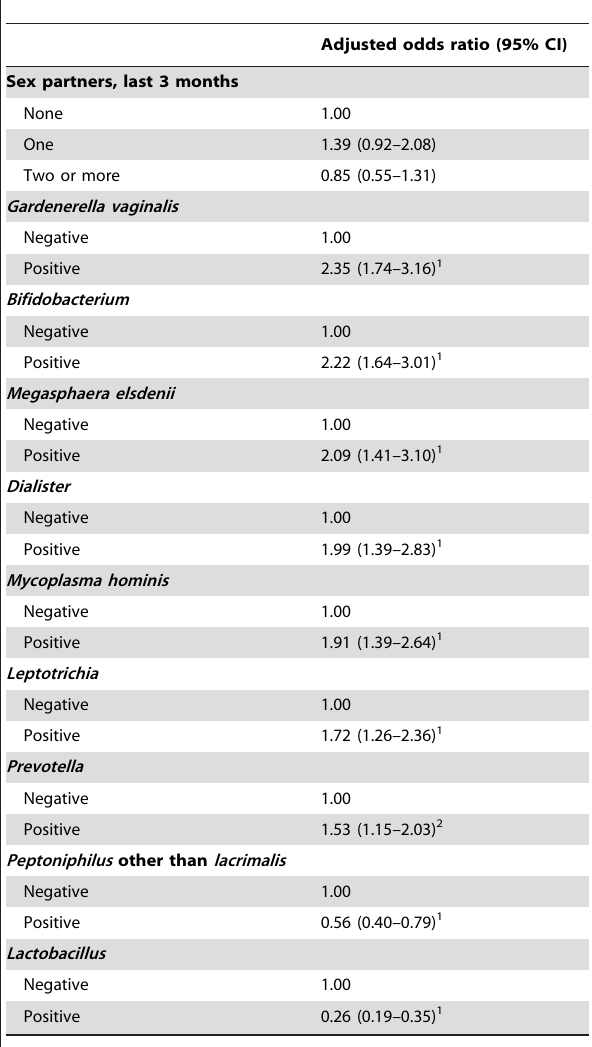
Table 4. Correlates of bacterial vaginosis (Nugent score $ 7) in multivariate